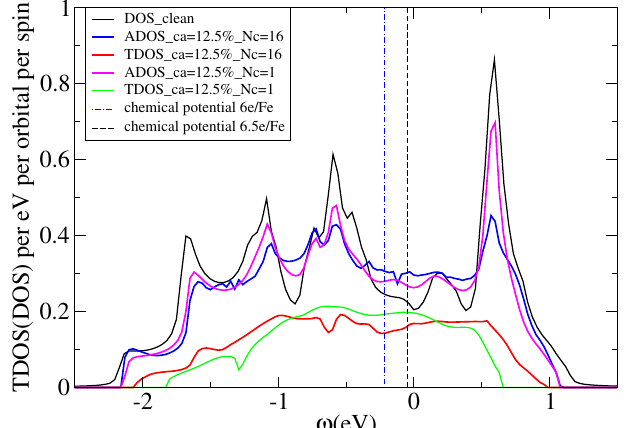
Figure 45. The average and typical density of states of KFe 2 Se 2 with 12.5% Fe vacancy concentration calculated by multiband DCA and TMDCA with cluster size N c = 1 and N c = 16, compared with the average density of states of the clean (no vacancy) KFe 2 Se 2 . Reprint from